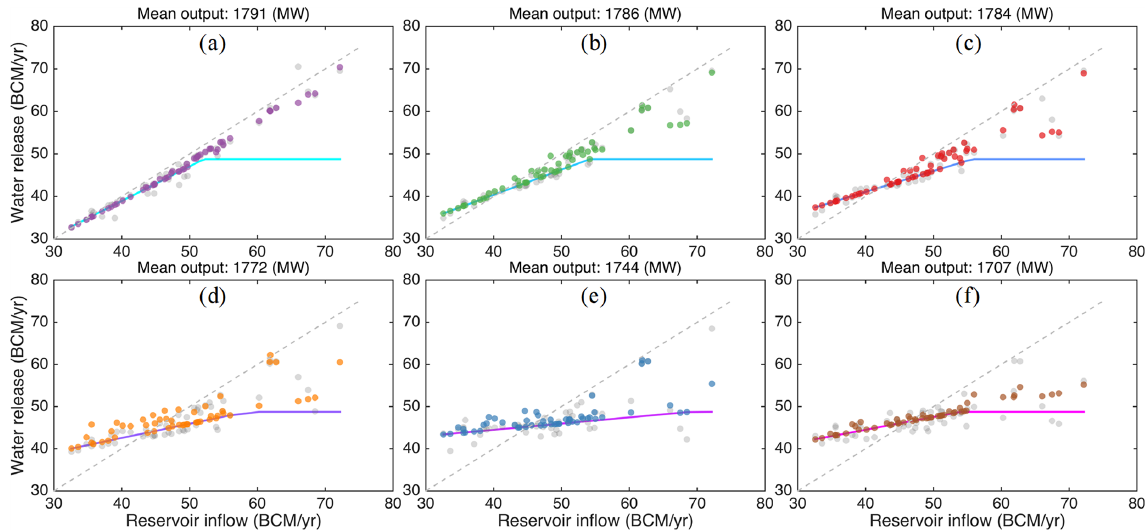
Figure 10. Relationship between annual reservoir inflow and releases using re-optimized reservoir operating rules. The drought policies are represented by lines, and the gray points refer to the inflow and release relationship from which drought policies are derived.